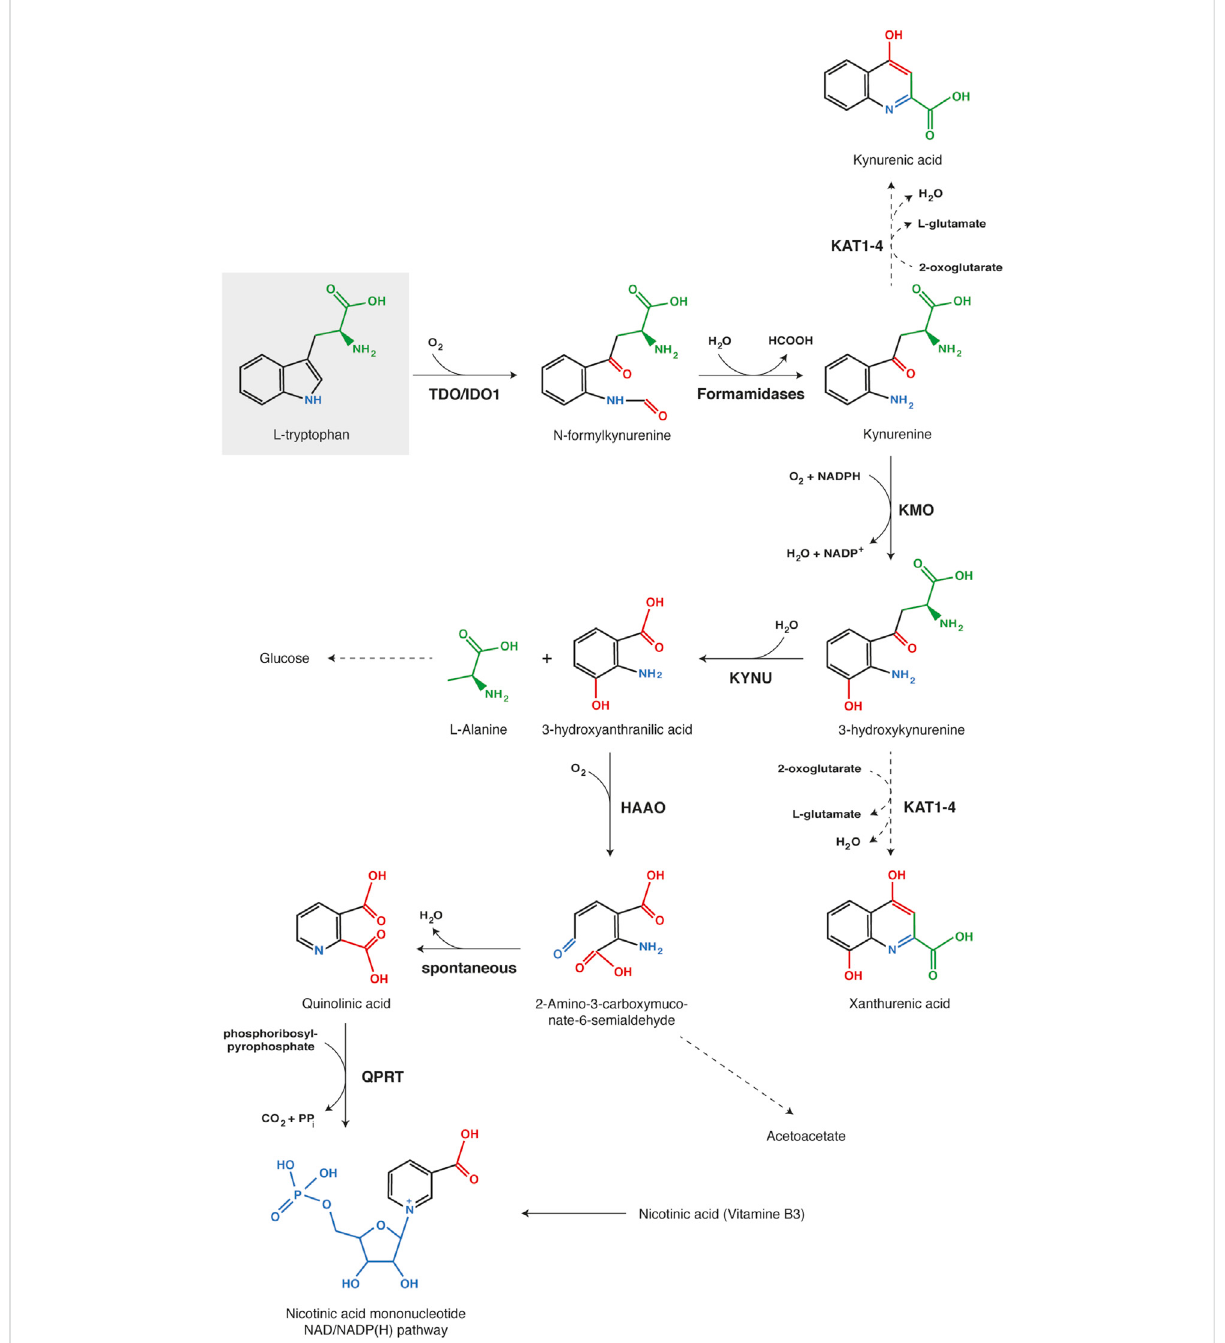
FIGURE 4 Kynurenine pathway of tryptophan catabolism. Each chemical function modi fi ed along the process is indicated with a different color (red, blue orgreen).The fi rstreaction,tryptophanoxidationbyIDO1orTDO,isthelimitingstepofthemetabolicpathway.Abbreviations:TDO,Tryptophan2,3- dioxygenase;IDO1,Indoleamine2,3-dioxygenase1;KMO,kynurenine3-monooxygenase;KYNU,kynureninase;HAAO,3-hydroxy-anthranilate3,4- dioxygenase; QPRT, Quinolinate phosphoribosyl transferase; KAT1-4, Kynurenine aminotransferase